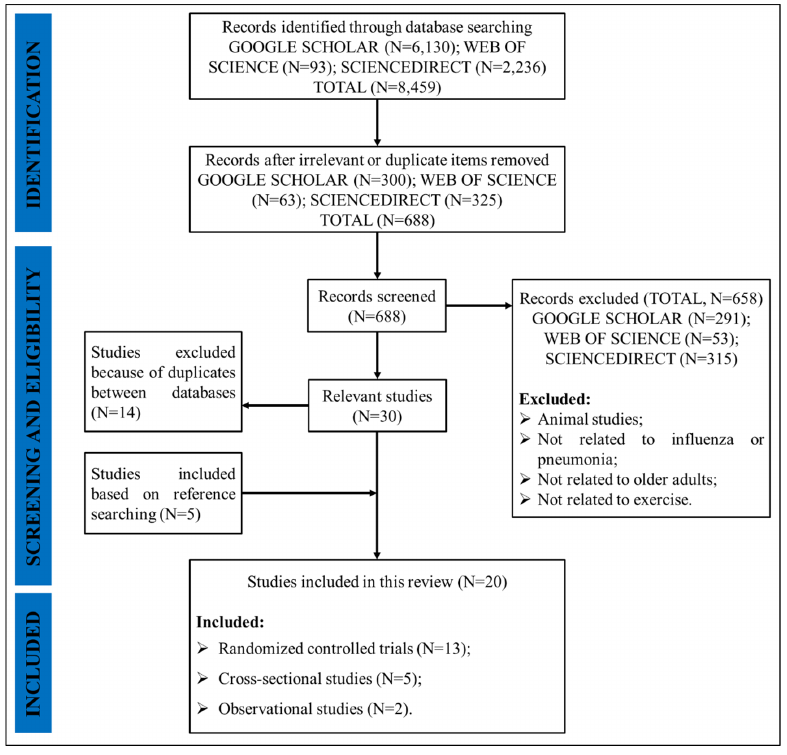
Figure 1. The search flowchart.